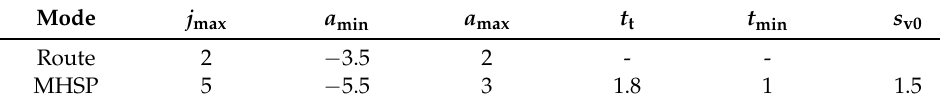
Table A2. Driving Parameters.